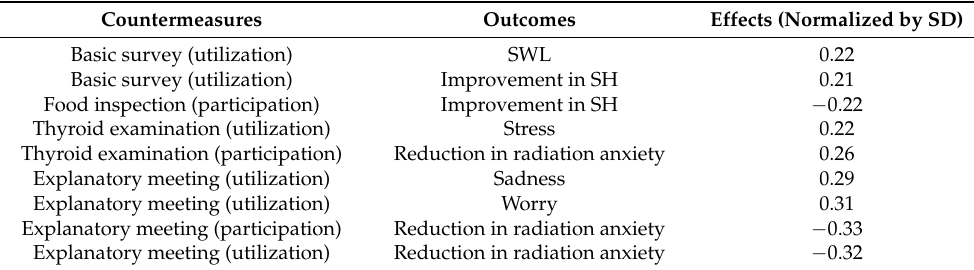
Table 6. Effects of countermeasures on outcomes. The differences in outcomes according to radiological countermeasures were regarded as effects. The values were normalized using the standard deviation (SD) of the scores for each